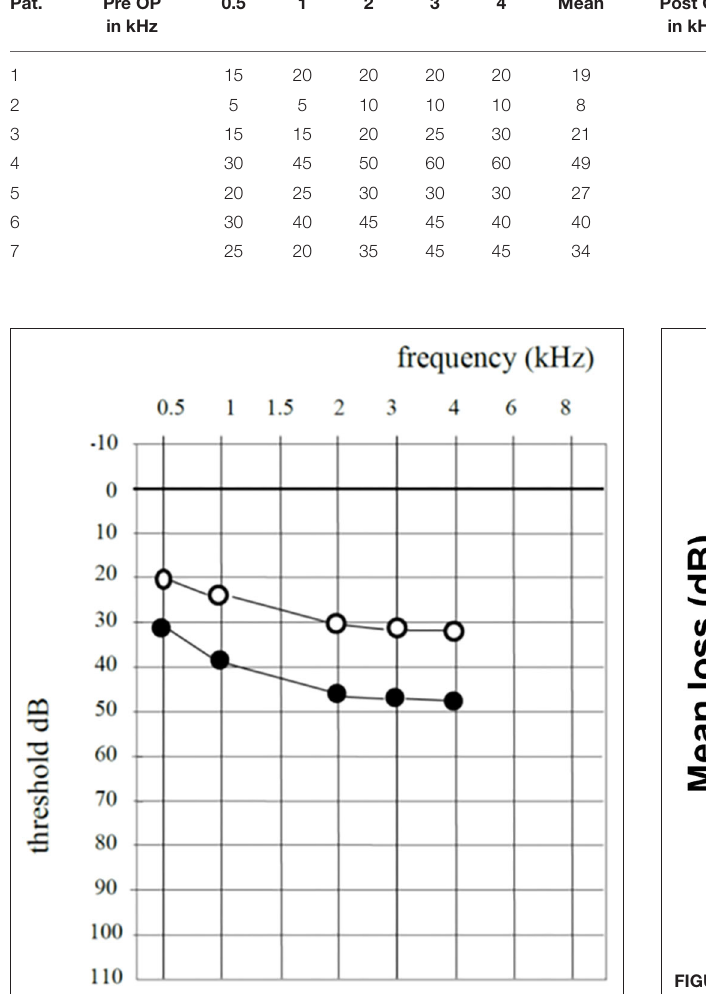
FIGURE 1 | Mean hearing threshold in cohort group.